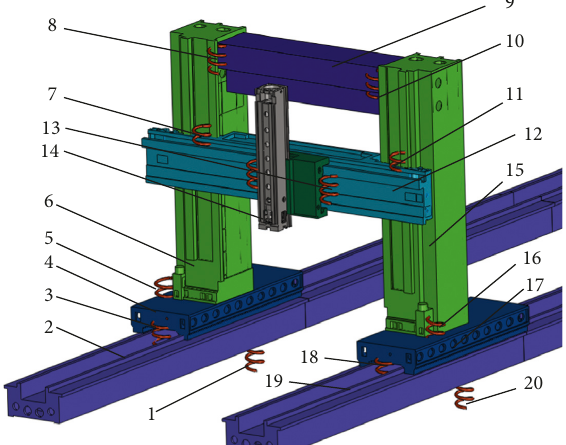
Figure 2: Dynamic model of the entire heavy machine tool.1—bed-concrete joint surface; 2—bed body; 3—slide-bed joint surface; 4—slide; 5—pillar-slide joint surface; 6—pillar; 7—beam-left column joint surface; 8—left column-connection beam joint surface; 9—connection beam; 10—right column-connection beam joint surface; 11—right column-beam connection surface; 12—beam; 13—carriage surface; 14—spindle; 15—pillar; 16—pillar-slide joint surface; 17—slide; 18—slide-bed joint surface; 19—bed body; 20—bed-concrete joint